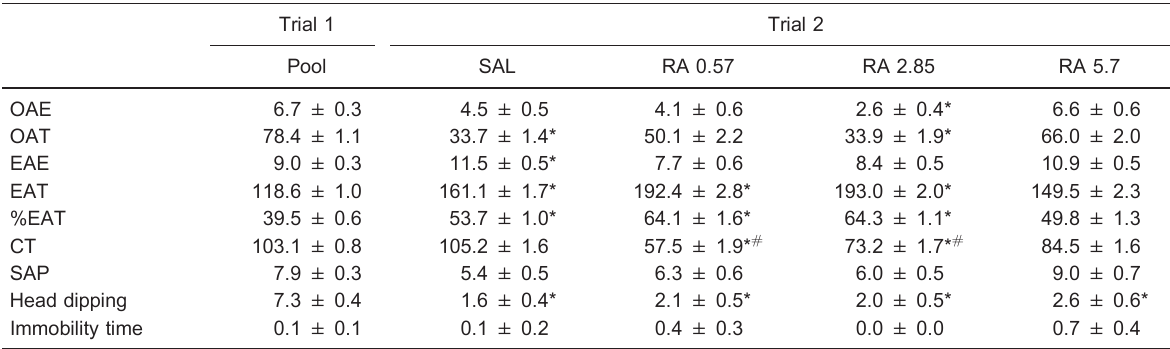
Table 3. Effects of H2 antagonist ranitidine (RA) microinjected into the cerebellar vermis on the behavior of mice in Trials 1 and 2 in the elevated plus maze